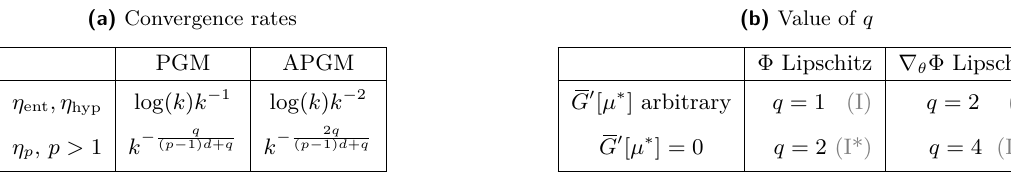
Table 2 (a) Upper bounds on the convergence rates of F ( f k ) − inf F for Algorithm 1 (PGM) and 2 (APGM). (b) The value of q that appears in the rate depends on the regularity of Φ and on whether G ′ vanishes at optimality or not. This defines 4 settings referred to as (I), (I*), (II) and (II*). Upper bounds are derived in Theorem 8, lower bounds are proved in Section